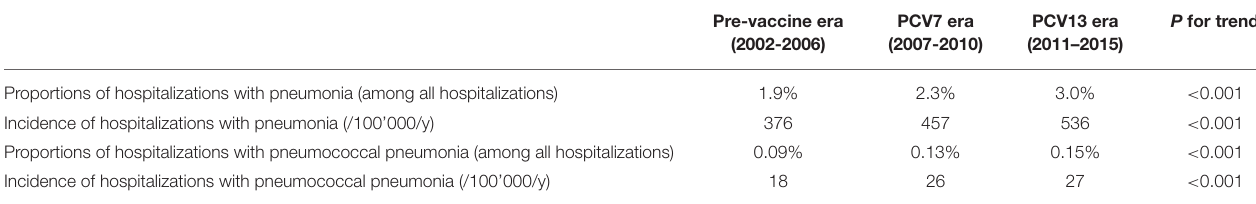
TABLE 2 | Hospitalizations with pneumonia and pneumococcal pneumonia over time.